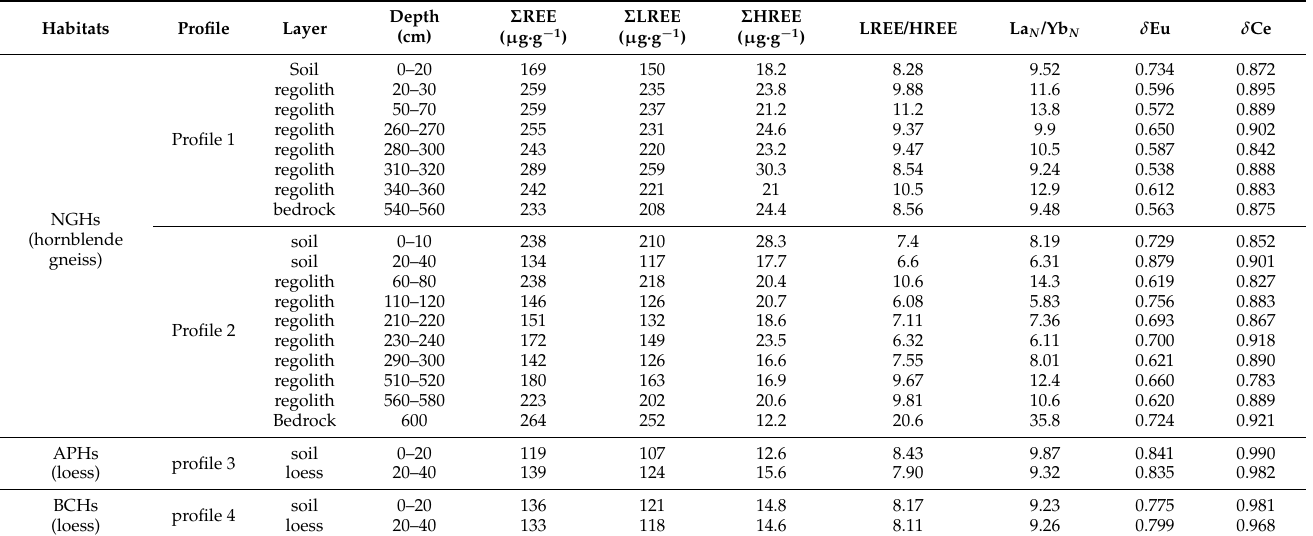
Table 2. Parameters on REEs distribution characteristics along profiles in various habitats, Hebei